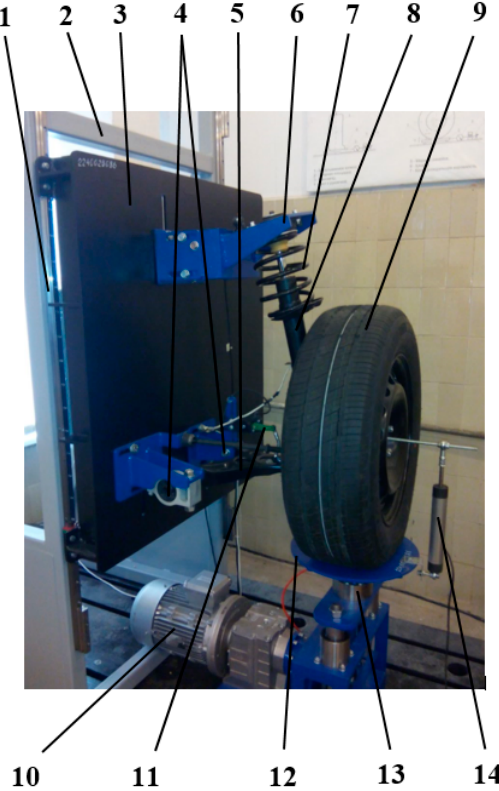
Figure 2. Full-scale stand of the front right part of the suspension of the VW PASSAT CC car. The stand (Figure 2) includes a base 2, on which two symmetrically arranged vertical guides 1 of the movable load 3—a simulator of the “right front quarter” of the VW PASSAT CC car body—are fixed. The lower support 4 (silent block) of the right front suspension arm 5 is fixed to the movable load and and the upper support 6 of the shock strut 8 of the right front wheel 9. The elastic element 7 of the right front wheel is mounted on the shock strut. The composition of the stand also includes adjustable drive motor 10, the gear actuator support of the vibrator 12, 11 gauge “level” right front wheel, the sensor 13 measuring the force acting from the side wheel bearing 9 12 vibrator, 14 gauge measuring “bending the wheel”, the monitor 15 personal computer, recording the measured parameters and the control unit 16 of the degree of dissipation of adaptive suspension and oscillation frequency supports of the vibrator. The sensor 14 actually measures the distance from the center of the wheel 9 to the support 12 of the vibrator, i.e., the “dynamic radius” of the wheel. When the wheel is detached from the support, this sensor also measures the total distance from the center of the wheel to the support of the vibrator. However, in this case the measured value is equal to the sum of “static radius” wheels and a value of “rebound wheels”—the distance between the wheel surface and support. Thus, simulation of the vehicle on uneven, i.e., the simulation of the vertical oscillatory motion of a wheel, carried out by implementing a vertical reciprocating motion of the support 12. Moreover, the speed of movement along the irregularities is modeled by selecting the appropriate oscillation frequency of the support 12 and can be smoothly “changed” by adjusting the speed of the drive motor 10. “The height of the irregularities”, i.e., the oscillation amplitude of the support 12, can be continuously adjusted. However, in our experiments, the “height of the irregularities” was unchanged and was equal to 50 mm. All measurements were recorded on the PC 15, and the control of the frequency of vibrations of the support and of the degree of dissipation of the adaptive shock absorber were carried out using the control complex 16.